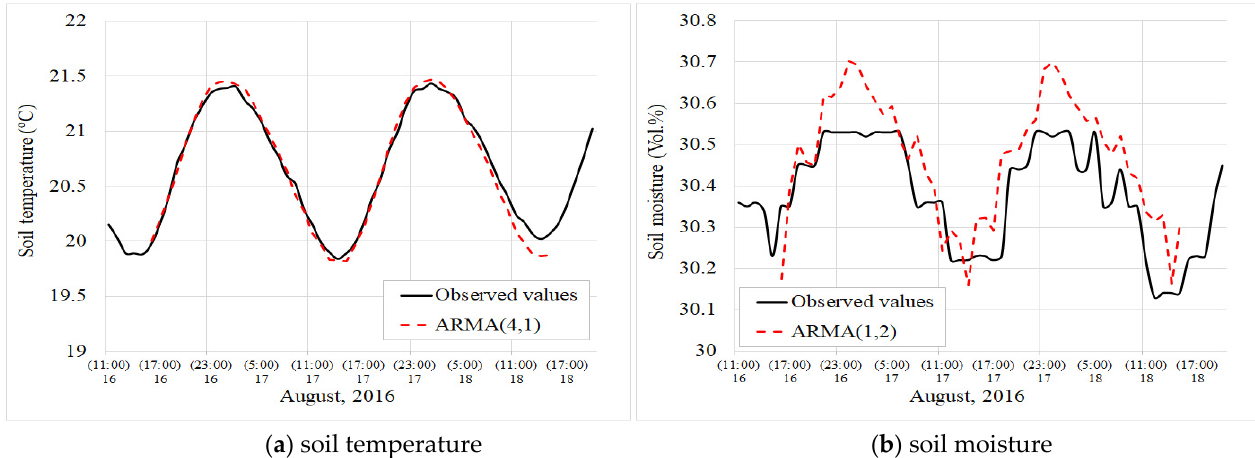
Figure 5. An example of 48 h length gaps filling via the extended ARMA model with exogenous climate variables. Calculated by the authors based on hourly time series, the data of monitoring network in Poluyamki, Altai Krai, Russia.